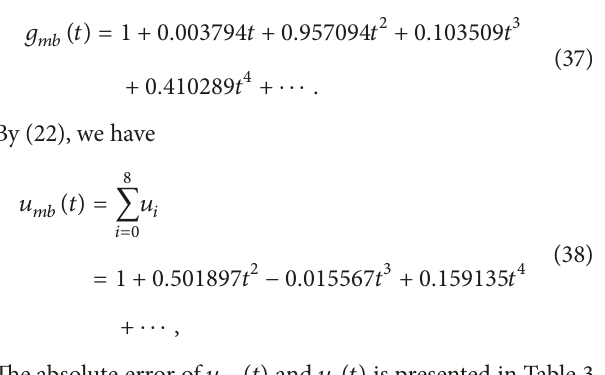
and modified Bernstein polynomials (21) of 𝑔(𝑡) with k=3 are (𝑡) = 1 + 0.003794𝑡 + 0.957094𝑡 2 + 0.103509𝑡 𝑔 𝑚𝑏